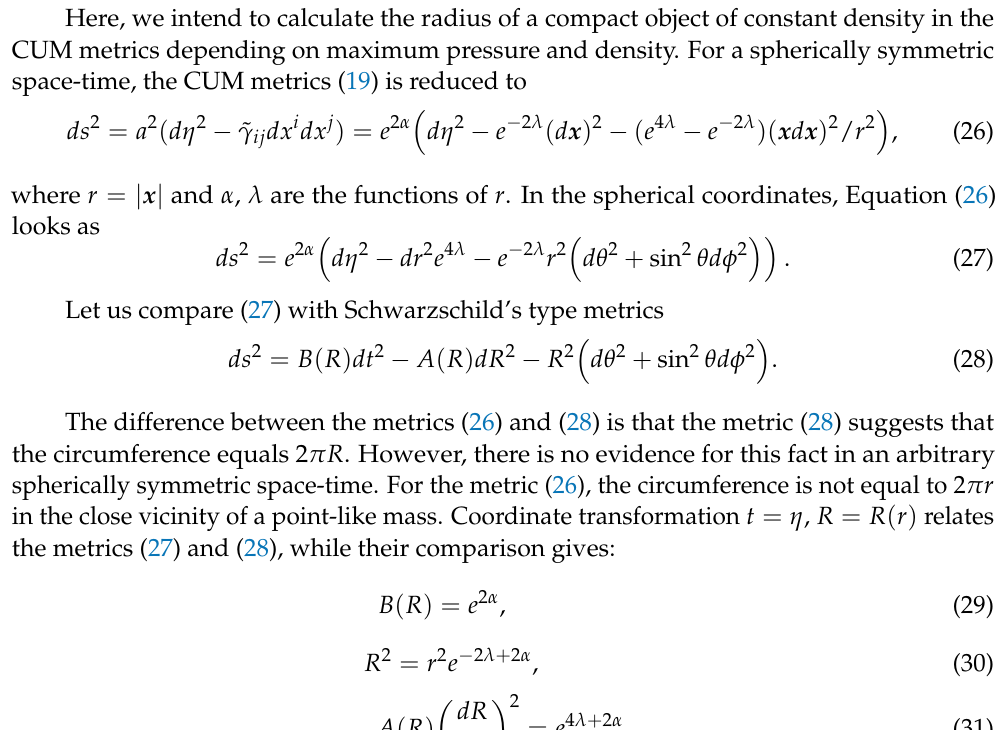
Figure 4. ( a ) A compact object of uncompressible fluid with the radius of r f in the CUM metrics (27) looks as a shell ( b ) with the boundaries r g < R i < R f in Schwarzschild’s type metric, where r g is a Schwarzschild’s